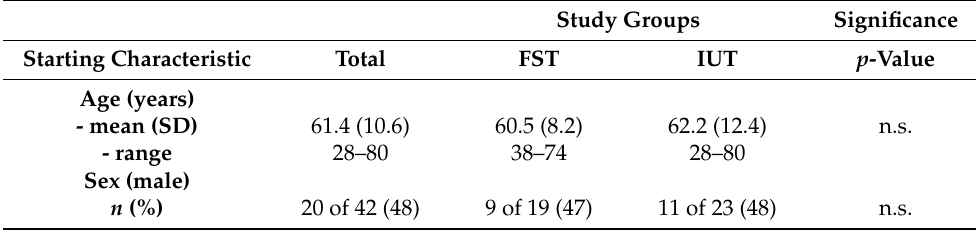
Table 1. Starting characteristics of treated patients in augmentation with autogenous dentin.